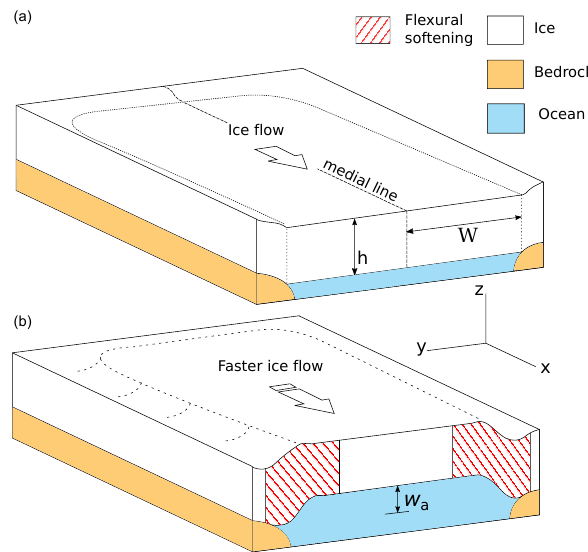
Figure 1. Schematic showing the flexural ice-softening mechanism for a confined shelf, together with the geometry of the problem de- scribed in Sect. 3. The top panel (a) shows the situation with no tidal uplift, and the bottom panel (b) shows how ice flow is enhanced as ice is softened in the shear margins due to flexural stresses gener- ated by a vertical tidal motion ( w a ). W denotes ice shelf half-width, and h is local ice